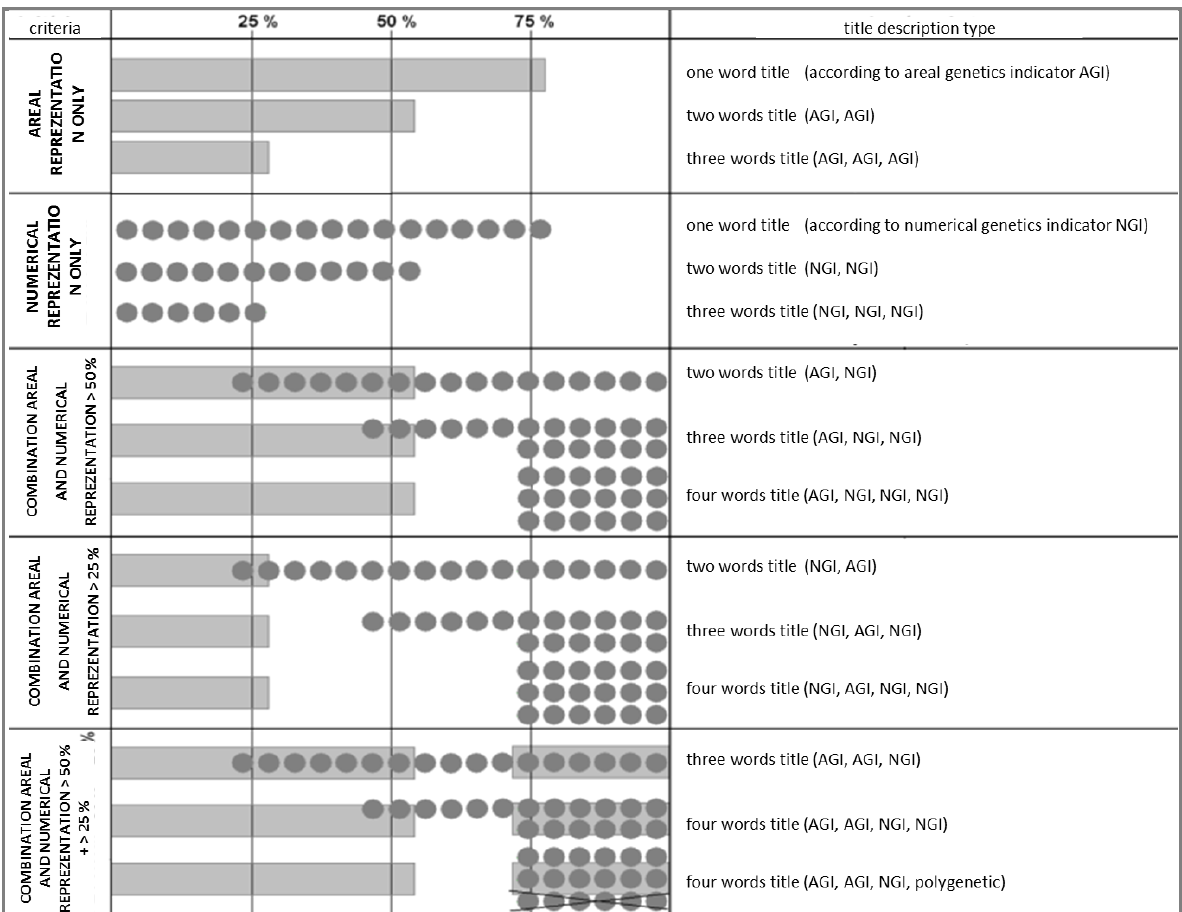
Fig. 6. The classification scheme of defined post-industrial landscapes into genetic types identified by one-to-four words